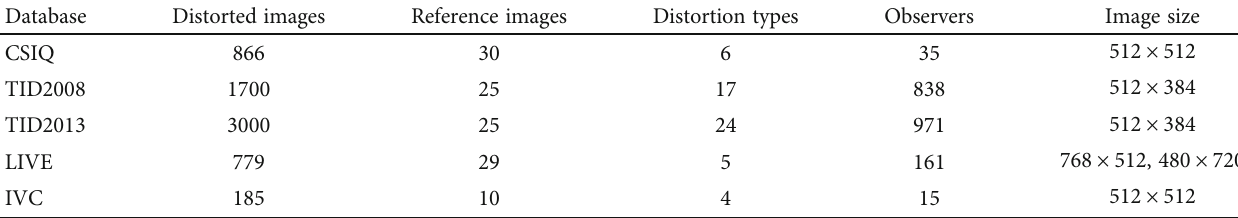
Table 1: Characteristics of the three databases for IQE.